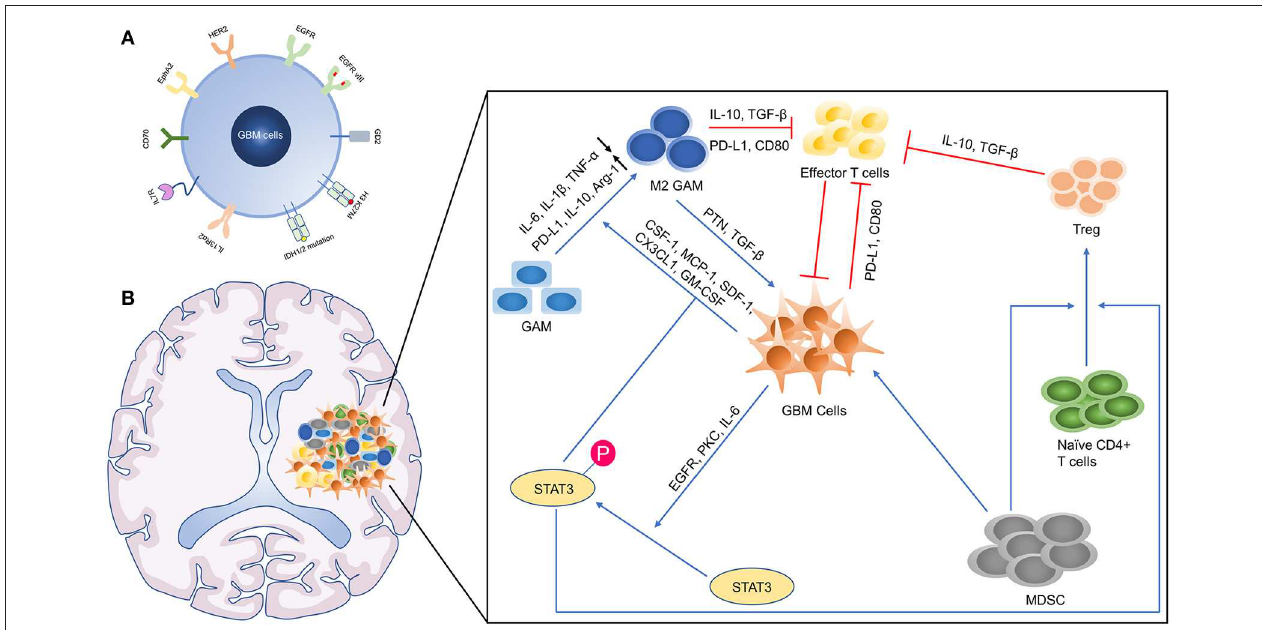
FIGURE 4 | The microenvironmental landscape of GBM. (A) The GBM associated antigens. HER2, Human epidermal growth factor receptor 2; EGFR, epidermal growth factor receptor; GD2, disialoganglioside 2; H3 K27M, mutated histone H3 K27M; IDH, isocitrate dehydrogenase; IL13R α 2, interleukin-13 receptor alpha 2; EphA2, ephrin-A2. (B) The Immunosuppressive GBM microenvironment. TNF- α , tumor necrosis factor α ; PD-1, programmed death 1; TGF- β , transforming growth factor- β ; Arg-1, arginase 1; GM-CSF, granulocyte-macrophage colony-stimulating factor; MCP-1, monocyte chemoattractant protein 1; SDF-1, stromal cell-derived factor 1; PKC, protein kinase